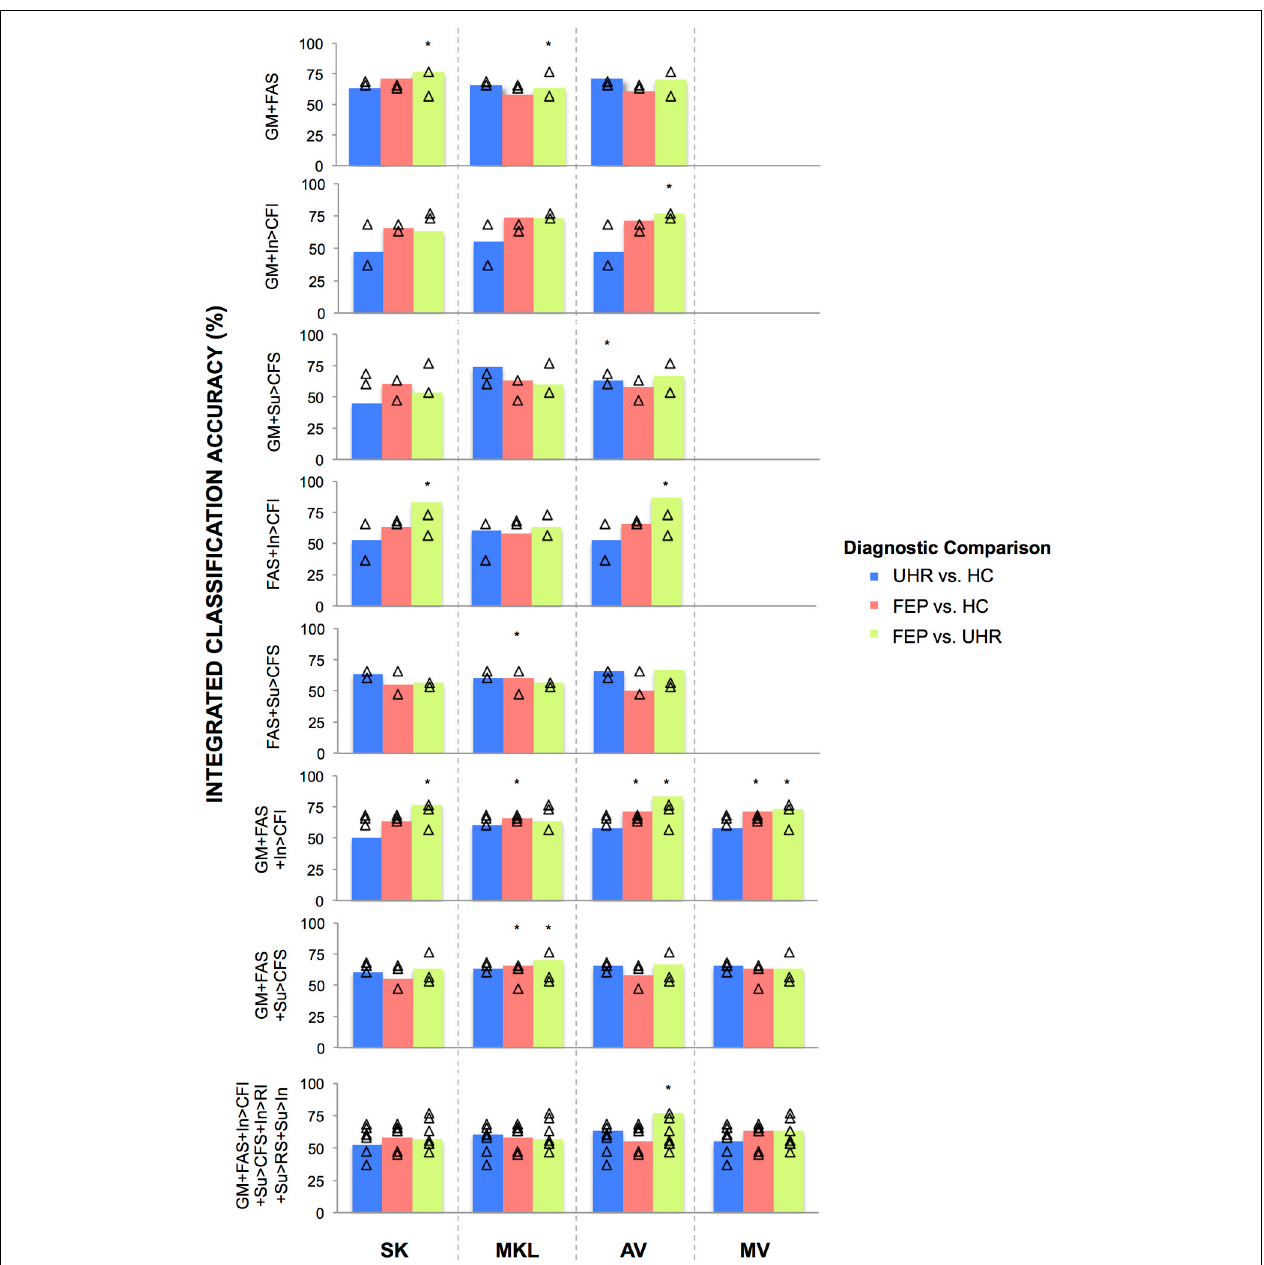
FIGURE 2 | Classifications accuracies achieved for discriminating FEP, UHR, and HC subjects, by integrating data in two-, three-, and seven-way combinations, using SK, MKL, AV, or MV. SK, Un-weighted simple sum of kernels; MKL, Multi-Kernel Learning; AV, Prediction Averaging; MV, Majority Voting; GM, grey matter; FAS, fractional anisotropy skeleton; In, generation of an overt verbal initiation response; Su, generation of an overt